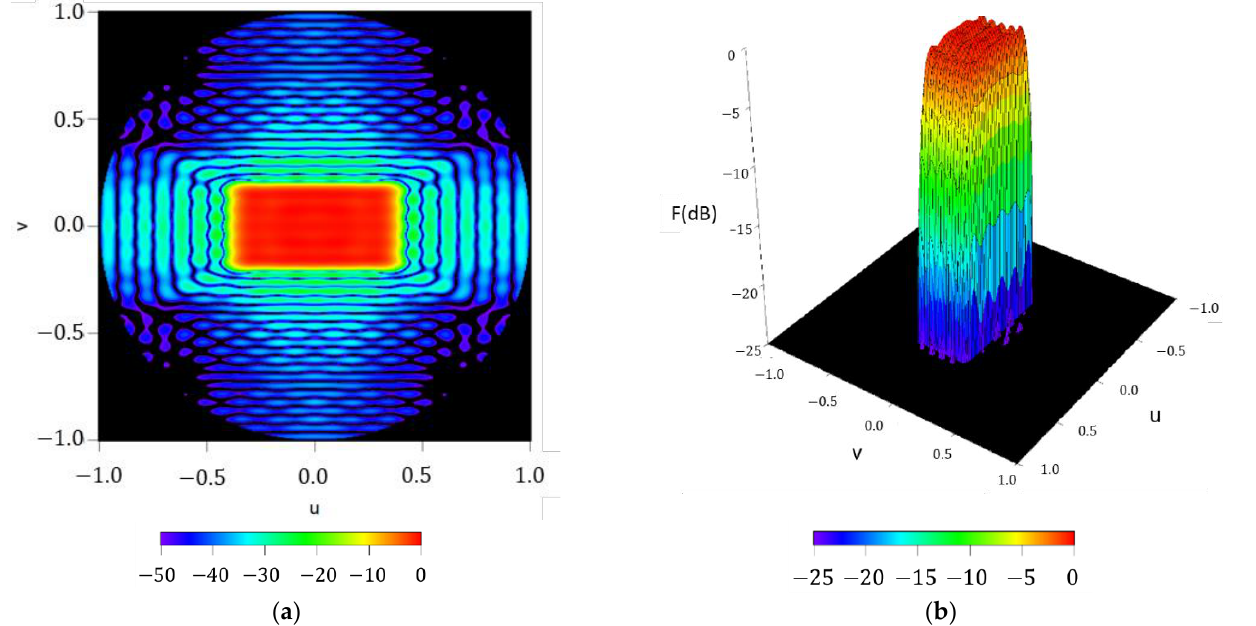
Figure 11. Reconstructed pattern for the case of a rectangular boundary of 20 ◦ × 40 ◦ by means of a discretized array antenna: ( a ) interpolated image with a threshold level set at − 50 dB ( b ) surface plot with a threshold level set at − 25